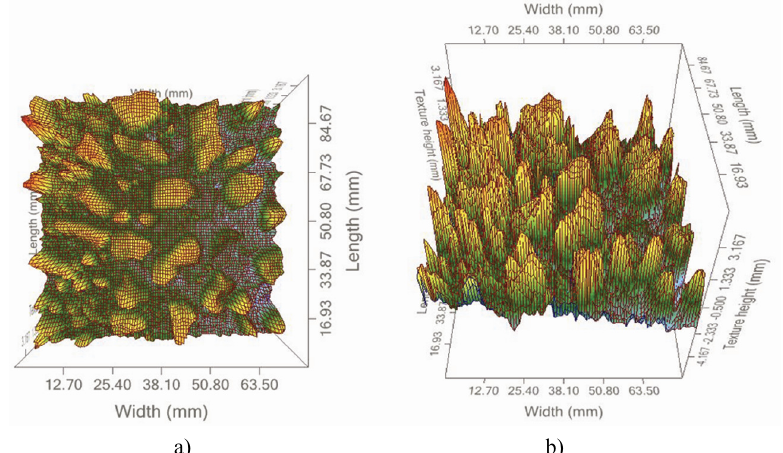
Fig. 5. 3-D surface rendering of the exposed aggregate concrete sample obtained from laser texture scanner: a) top; and b) side